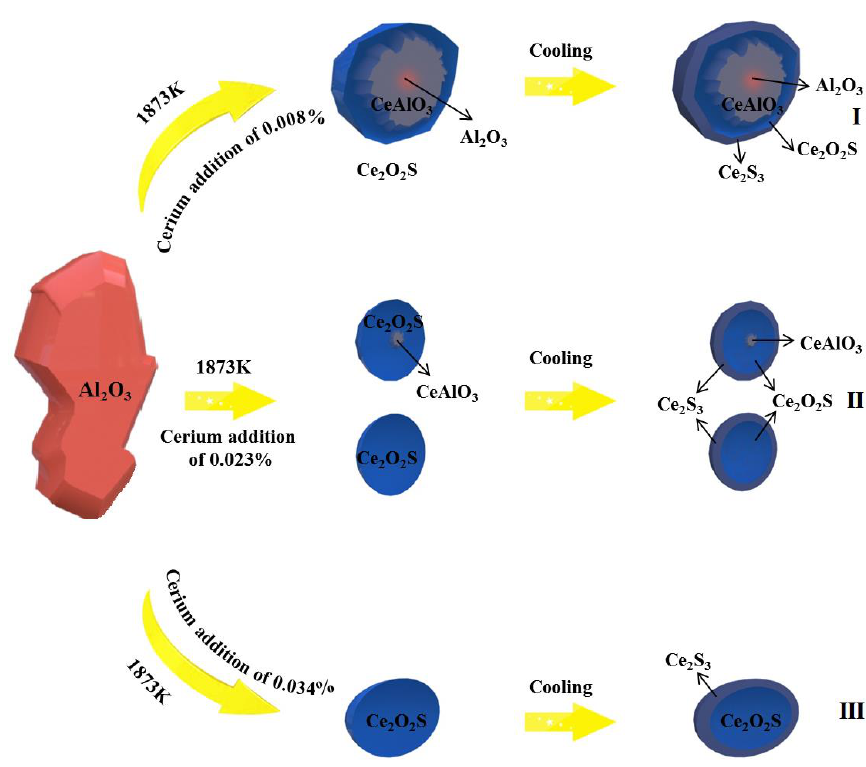
Figure 8. Inclusion evolution